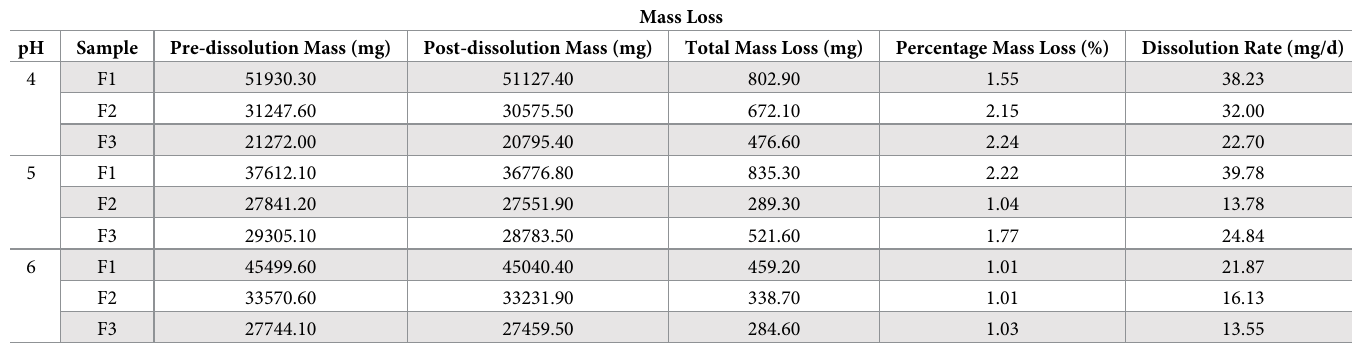
Table 1. Pre- and post-dissolution masses, total mass loss, percentage mass loss, and dissolution rate per day for all fossils at each pH tested.